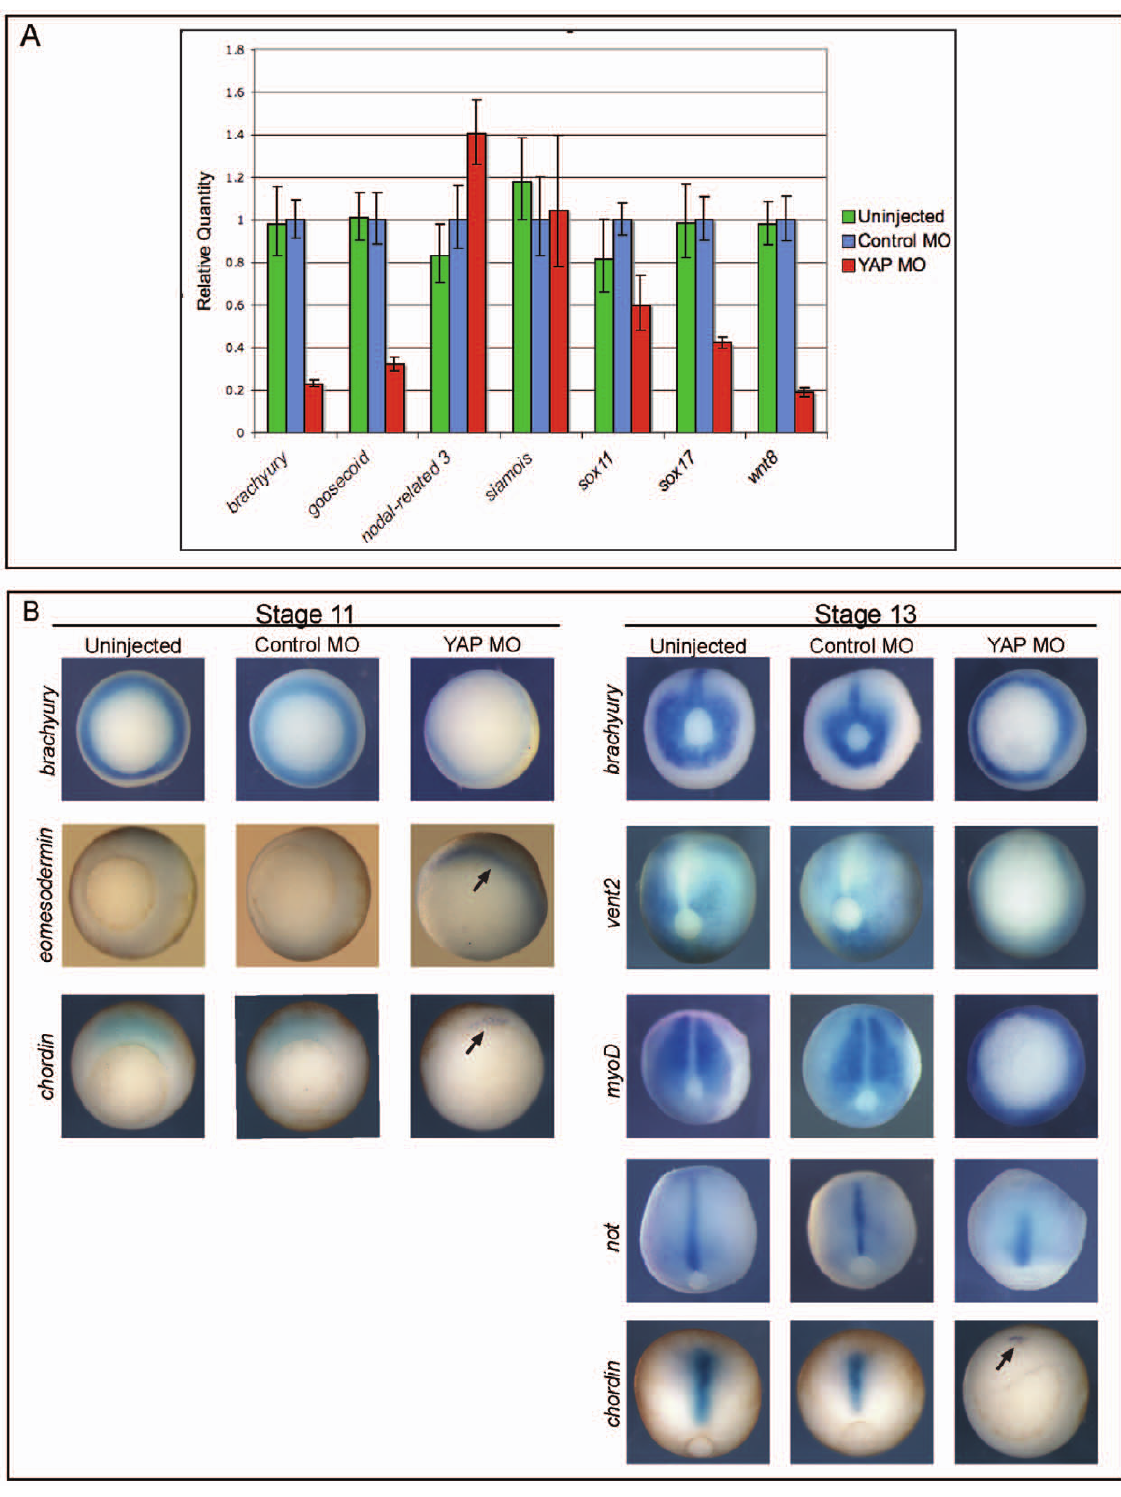
Figure 2. Germ layer markers are expressed in YAP morphant Xenopus embryos, but are temporally delayed. ( A ) qPCR analysis of mRNA from uninjected, control MO-injected, and xYAP MO-injected Xenopus embryos collected when controls reached stage 10.5/11. brachyury , goosecoid , wnt8 , sox11 , and sox17 mRNA levels were reduced, nodal-related 3 ( nr3 ) mRNA levels were increased and siamois mRNA levels remained unchanged in xYAP morphant embryos. ( B ) In situ characterization of mesoderm gene expression in uninjected, control MO-, and xYAP MO-injected Xenopus embryos. xYAP morphant embryos express each gene in the correct location, but the spatial pattern resembles an earlier developmental stage. For example, brachyury expression in the stage 11 YAP MO embryos is only faintly detected and brachyury expression in the stage 13 YAP MO embryo is indistinguishable from the control stage 11 pattern. chordin expression in the stage 13 YAP MO embryo remains confined to the dorsal blastopore lip (arrow), as is normal at stage 11; it has not elongated with the axial mesoderm as is normal at stage 13. eomesodermin expression in the